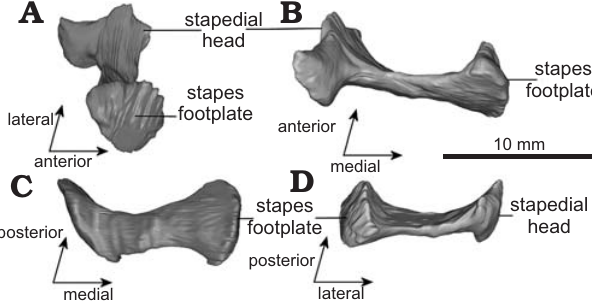
Fig. 4. Virtual reconstruction of the left stapes of the non-mammalian synapsid Pristerodon mackayi Huxley, 1868 (MB.R.985) from the Late Permian of Biesjespoort, South Africa; in medial ( A ), posterior ( B ), ventral ( C ), and anterior ( D )